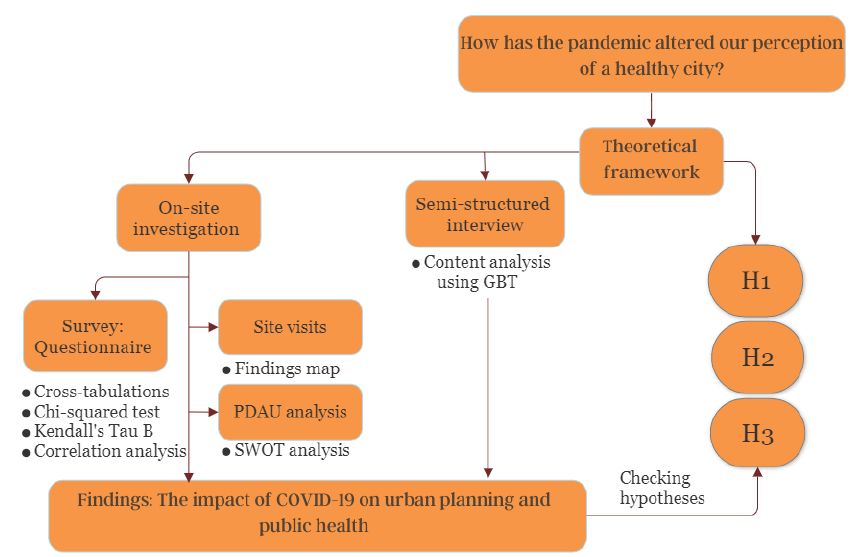
Figure 1. Model of the study. Source: authors.